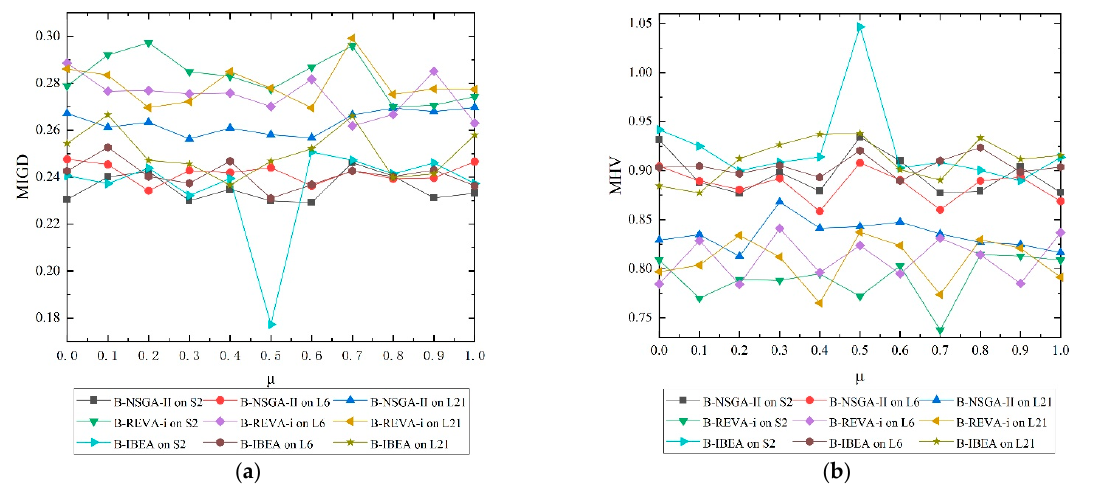
Figure 6. MIGD and MHV in relation to μ on different problem instances. ( a ) MIGD obtained by all algorithms; ( b ) MHV obtained by all algorithms.